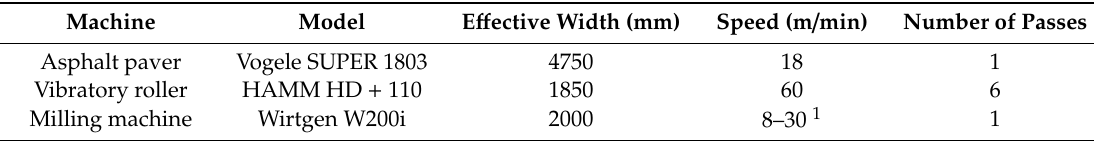
Table 8. Paving and milling machine